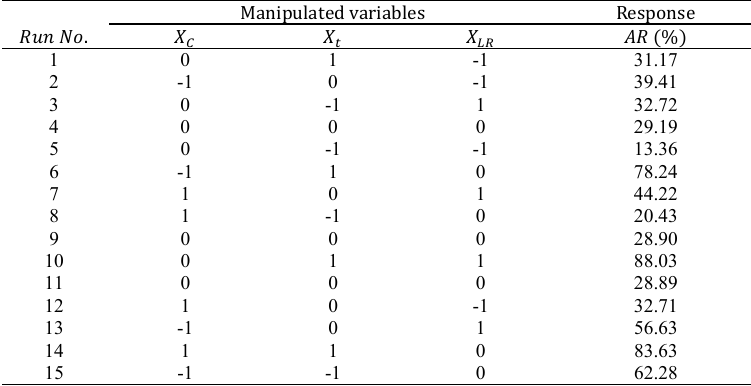
Table 4: Experimental design for three independent variables and the responses